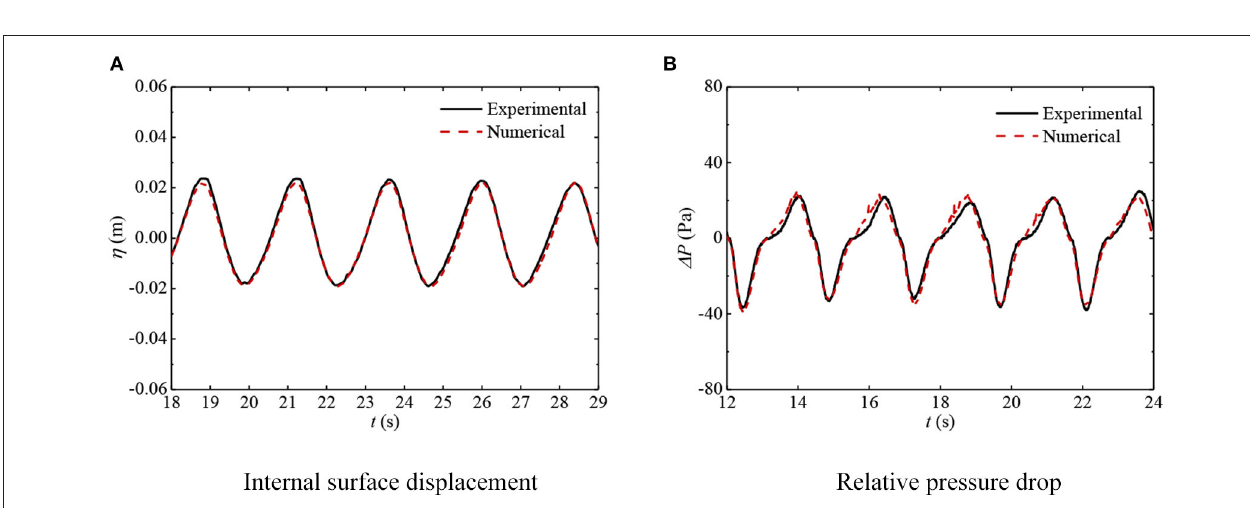
FIGURE 5 | Time series of internal surface displacements and relative pressure drops. In all cases, B = 1.5 a , d 2 = 0.2 m, H i = 0.03 m, and T = 2.4 s. (A) Internal surface displacement. (B) Relative pressure